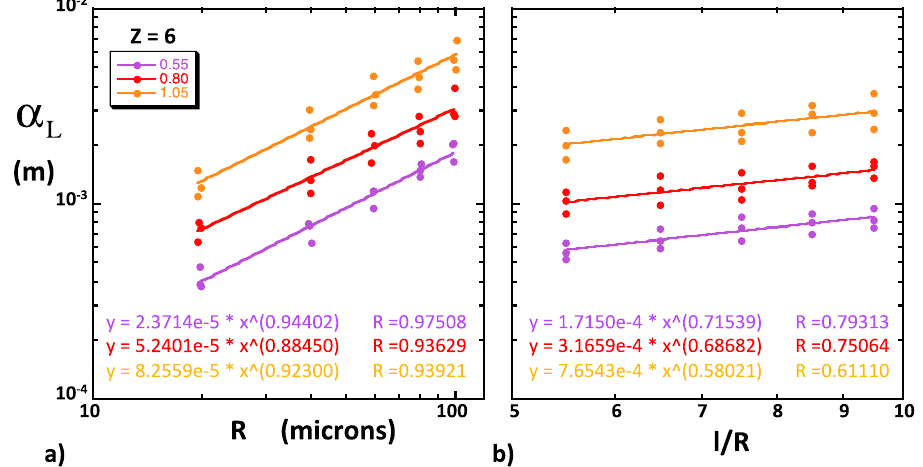
Figure 3. Approximate power law dependence of the simulated longitudinal dispersivities on ( a ) the network hydraulic radius R and ( b ) the bond length-to-radius ratio l / R . These simulations correspond to BCC networks realizations with CV ≥ 0.55 (indicated using the same colors as in Fig. 1). These simulations were performed with 10000 particles, Z = 6, U = 10 − 4 ms − 1 , l / R = 7.5 ( a ) and R = 40 × 10 − 6 m ( b ). The best fitting equations are indicated in matching colors. The simulations corresponding to CV = 0.05 and 0.30 are omitted because they produce results that depend on lattice type (see text).